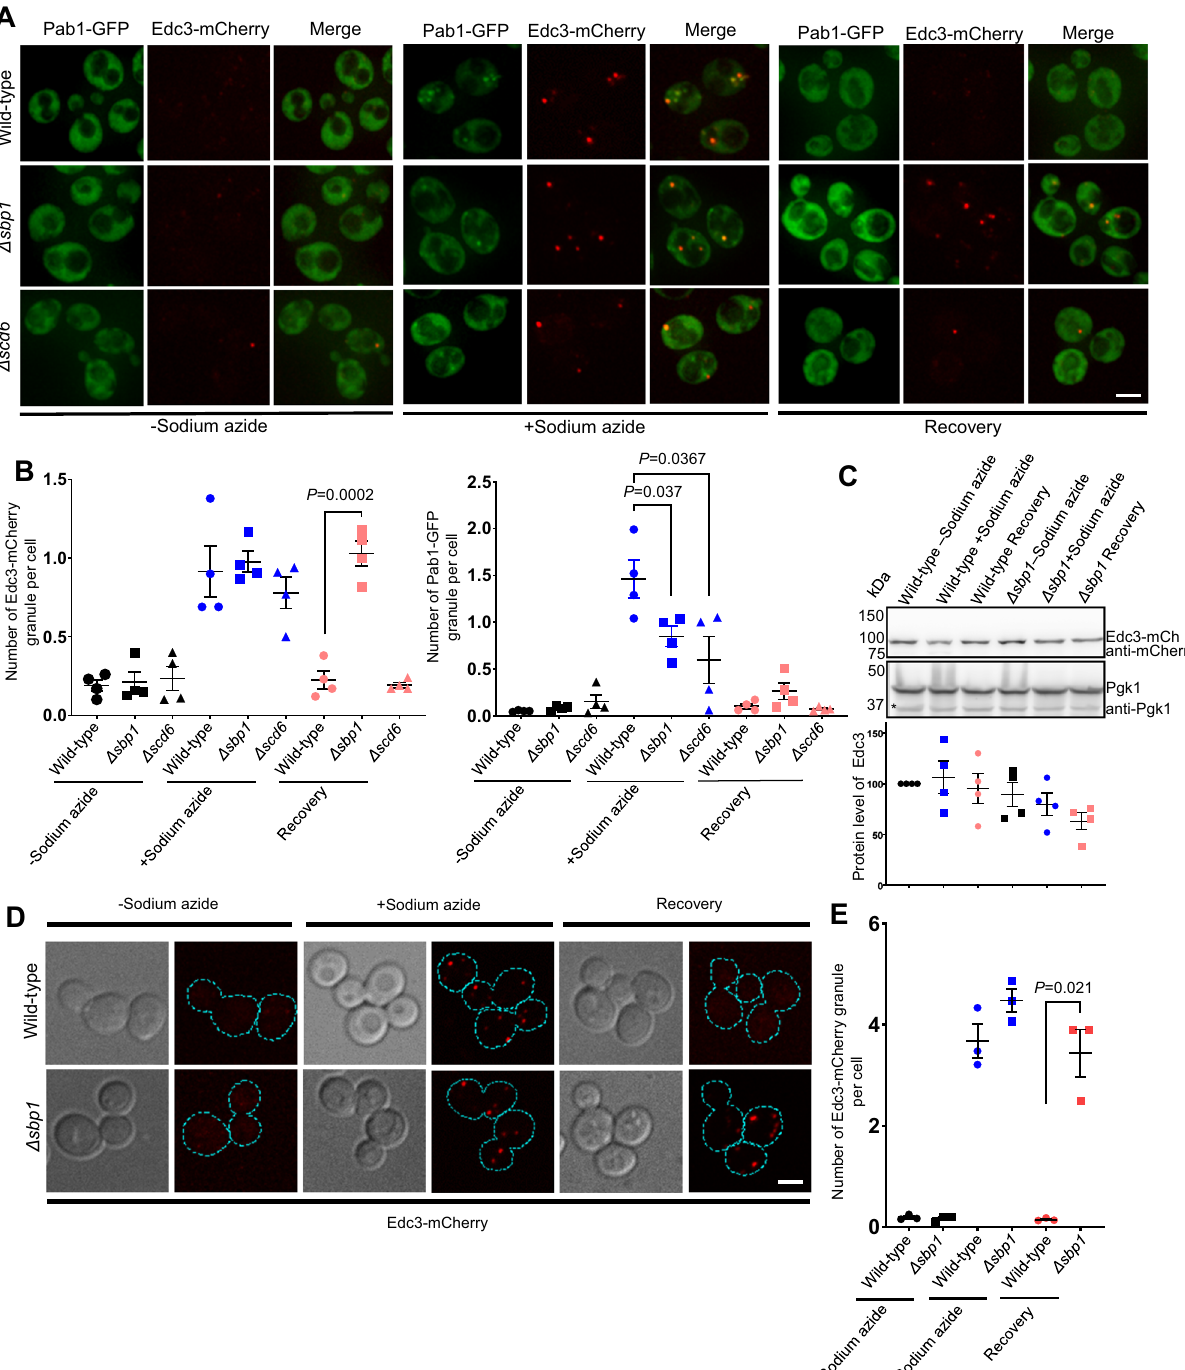
Fig. 1 Disassembly of Edc3 granules is defective in Δ sbp1 . A Δ sbp1 leads to Edc3 granule disassembly defect. Cells were cultured till 0.35 – 0.4 OD 600 and incubated for 30 min with or without 0.5% (v/v) sodium azide at 30 °C. Subsequently, cells were pelleted and washed thrice with glucose-containing medium. For stress recovery, the resuspended cells were grown for an additional 1 h at 30 °C in media without sodium azide. Scale Bar, 3 µ m. B Graph depicting the number of foci per cell in wild-type, Δ sbp1 and Δ scd6 strain in various culture conditions. Data plots represent mean ± SEM from of n = 4, where ‘ n ’ represents number of independent experiments. A two-tailed paired student t -test was used to calculate P -values. C Protein levels of Edc3- mCherry during conditions shown in A. Data plots represent mean ± SEM from of n = 4, where ‘ n ’ represents number of independent experiments. A two- tailed paired student t -test was used to calculate P -values. D Disassembly of endogenously tagged Edc3-mCherry granule in wild-type and Δ sbp1 after 1 h recovery. Scale Bar, 3 µ m. Dotted line in the images represents cell boundary. E Quanti fi cation of endogenously tagged Edc3-mCherry granule per cell in -sodium azide, + sodium azide and recovery experiment presented in D . Data plots represent mean ± SEM from of n = 3, where ‘ n ’ represents number of independent experiments. A two-tailed paired student t -test was used to calculate P